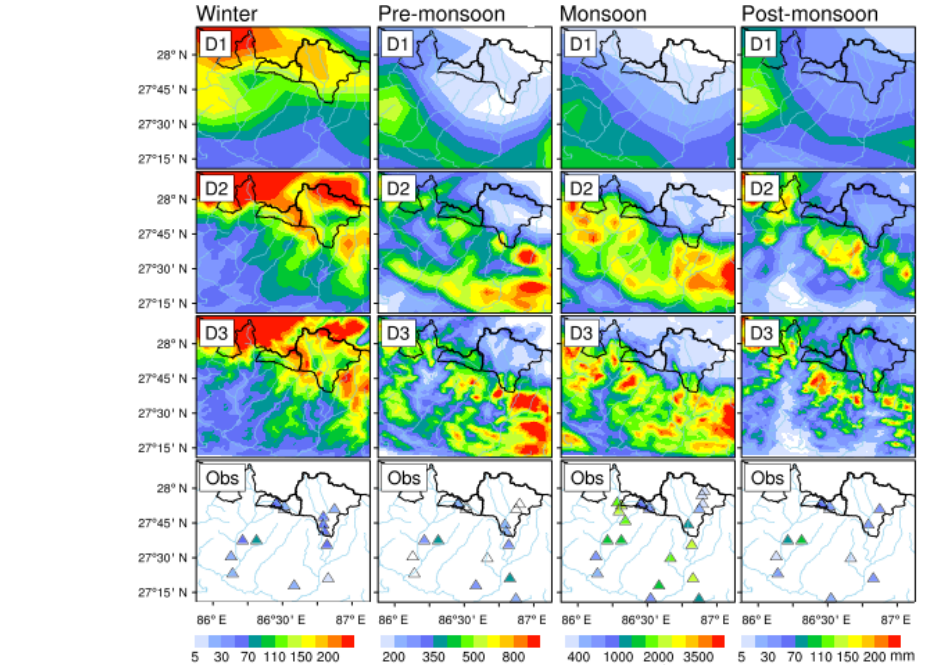
Figure 9. Spatial distribution of seasonal total precipitation at three WRF resolutions (D3, D2, and D1) and observations, with rivers in the Nepal region delineated in light blue and the political boundary of Nepal and the Khumbu (right) and Rolwaling (left) catchment boundaries given in black.